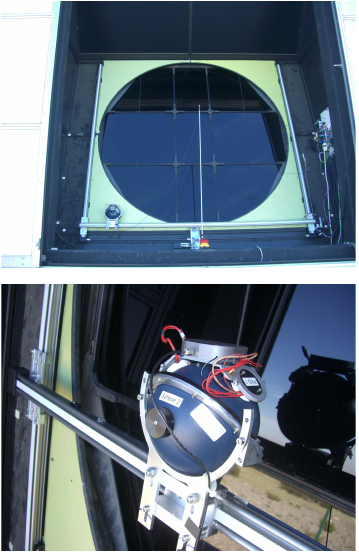
Figure 2. Full view of the XY scanner mounted to the aperture box of the Coihueco telescope 4 (upper photo). Detailed view of the integrating sphere with mounted flasher electronics (lower photo, grey case on top of the sphere), photodiode and LED head (upper